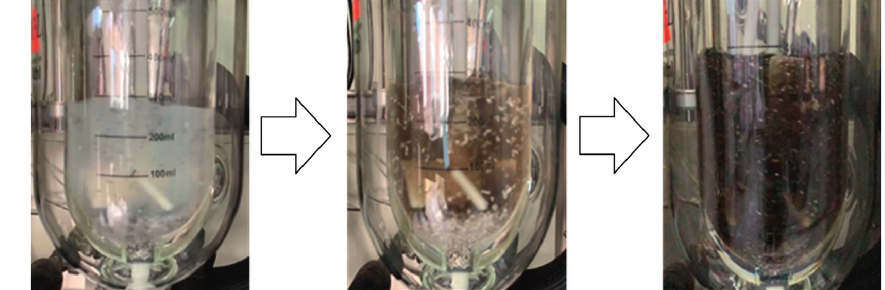
Figure 3: Induction process in synthesis of the Grignard